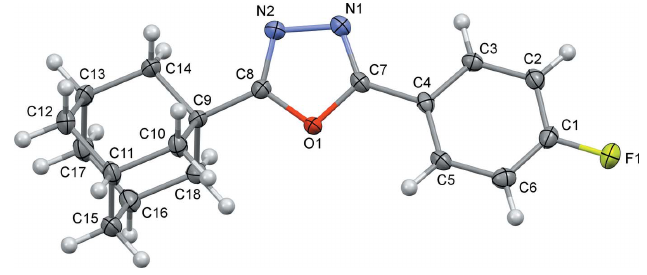
Figure 1 Molecular structure of compound (I), with the atom labelling and displacement ellipsoids drawn at the 50% probability level.